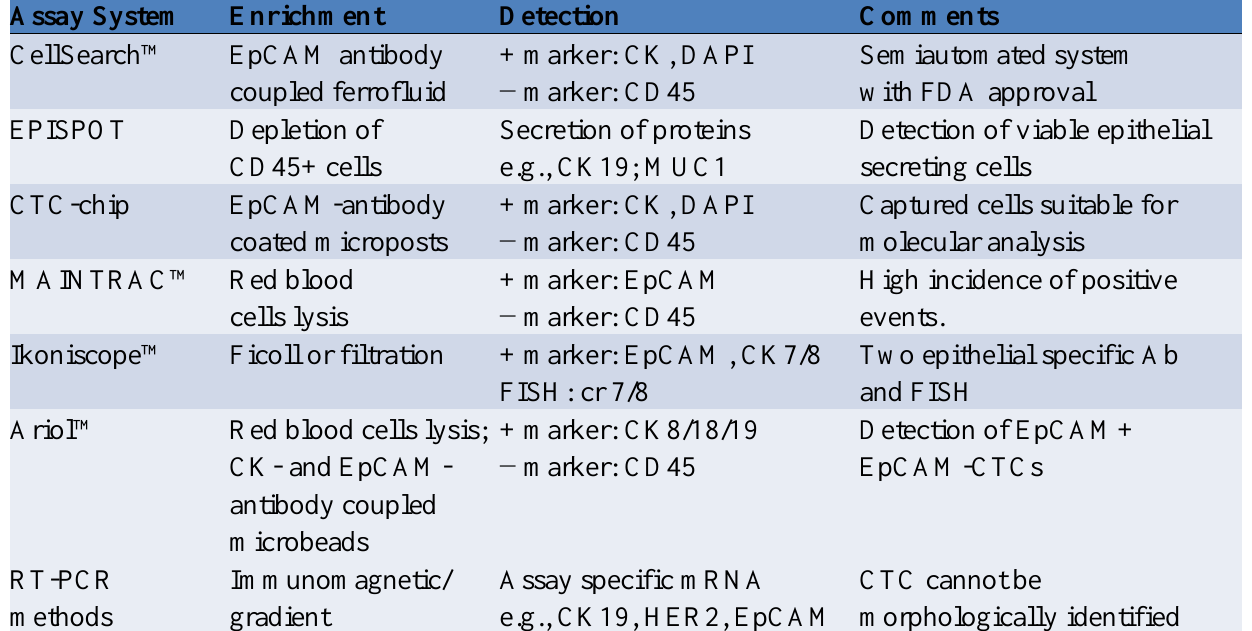
Table 3. CTC detection: A variety of tools exist for identification of CTC, with variation in enrichment and detection approaches.